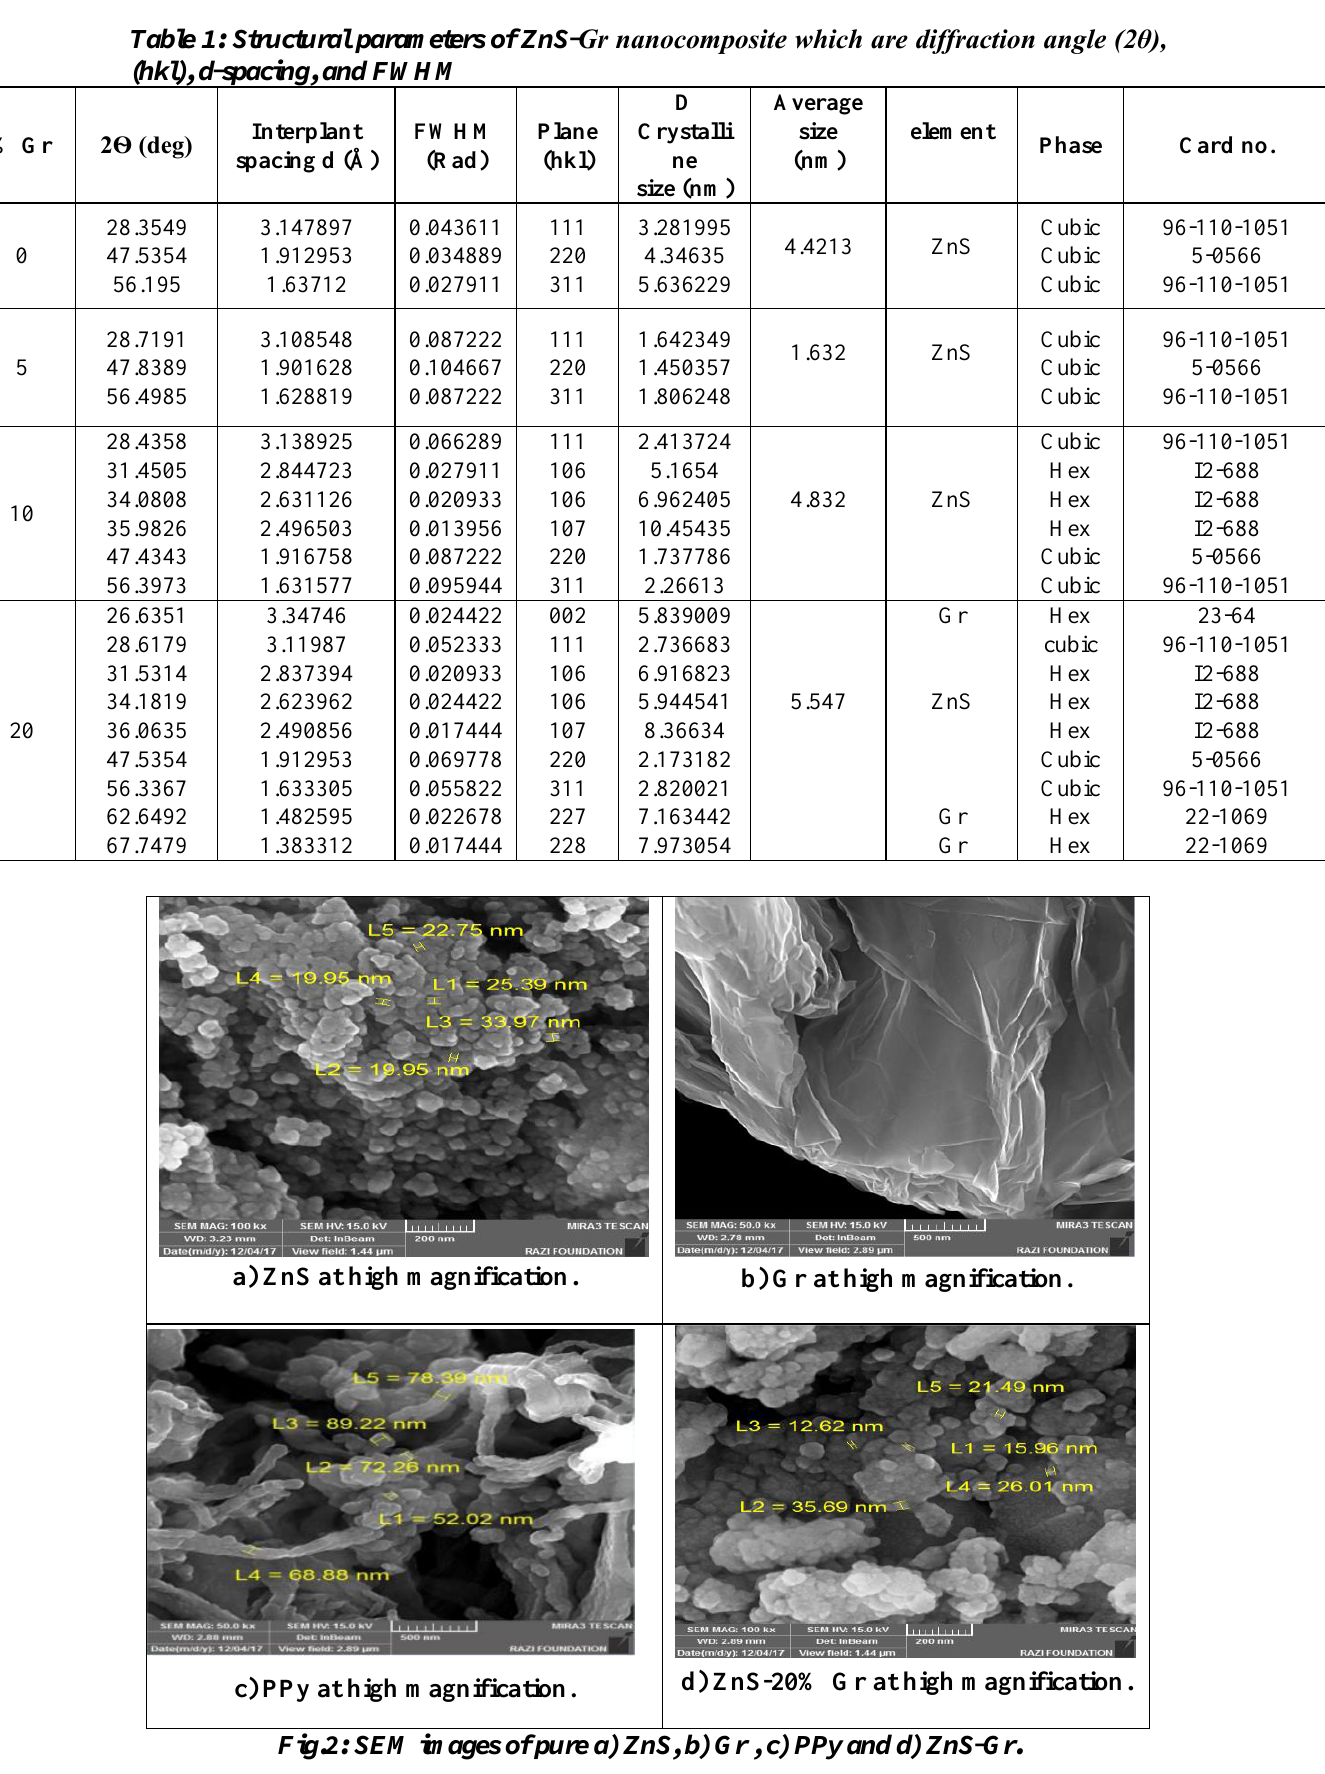
Fig.2: SEM images of pure a) ZnS, b) Gr , c) PPy and d)